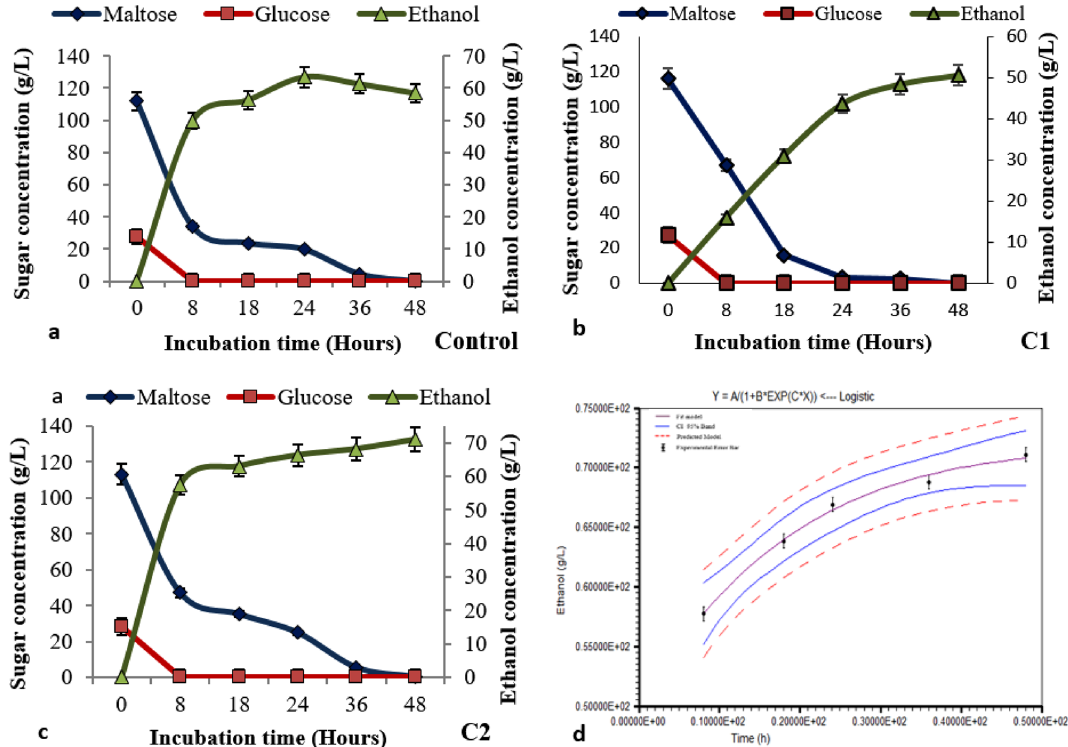
Figure 3. Time lapse changes in the maltose, glucose, and ethanol concentrations of black wheat wort after fermentation with different yeast strains ( a ) Standard yeast ( Saccharomyces cerevisiae ) as control ( b ) Strain C1 and ( c ) Strain C2 ( d ) Kinetic modelling of potential strain